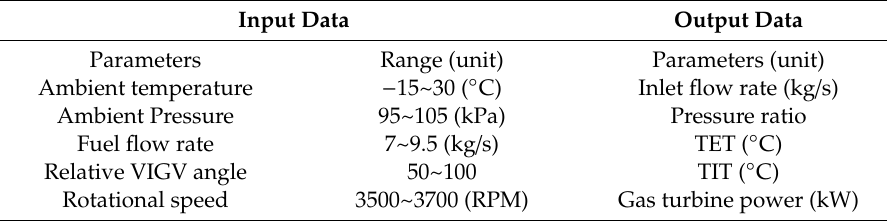
Table 3. Variation ranges of parameters for making database for black box model